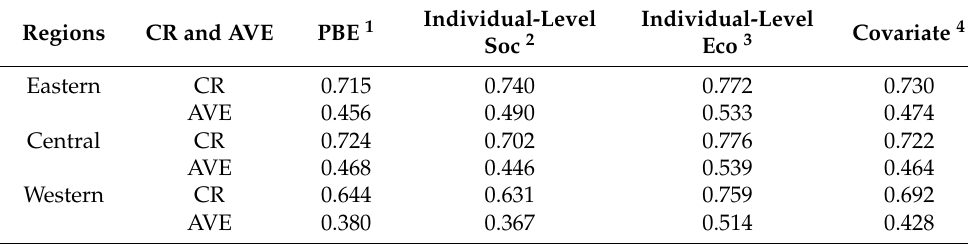
Table A1. Composite reliability (CR) and average variance extracted (AVE) for latent variables with multiple indicators.